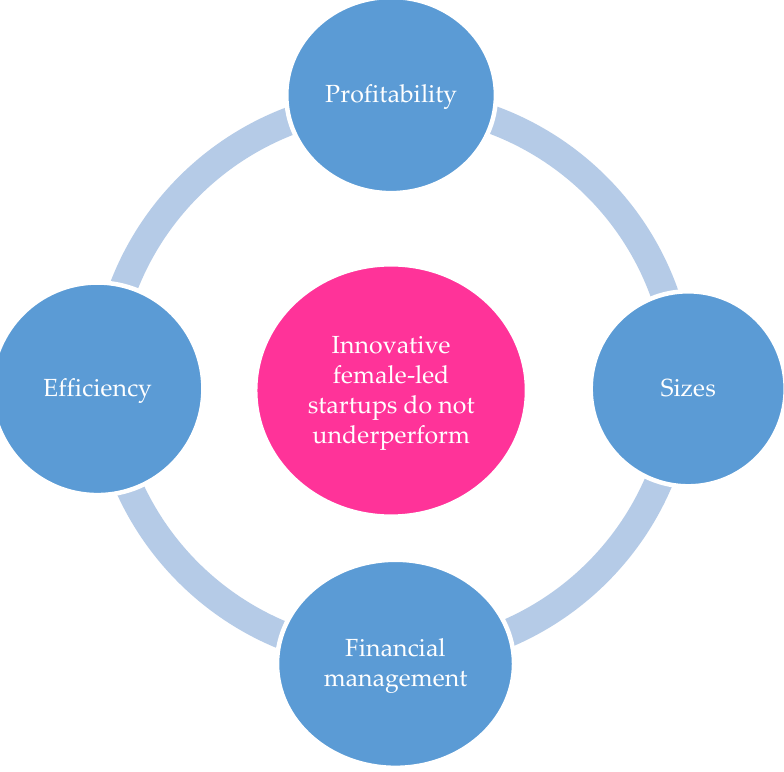
Figure 2. Testing the underperformance hypothesis. Our findings.